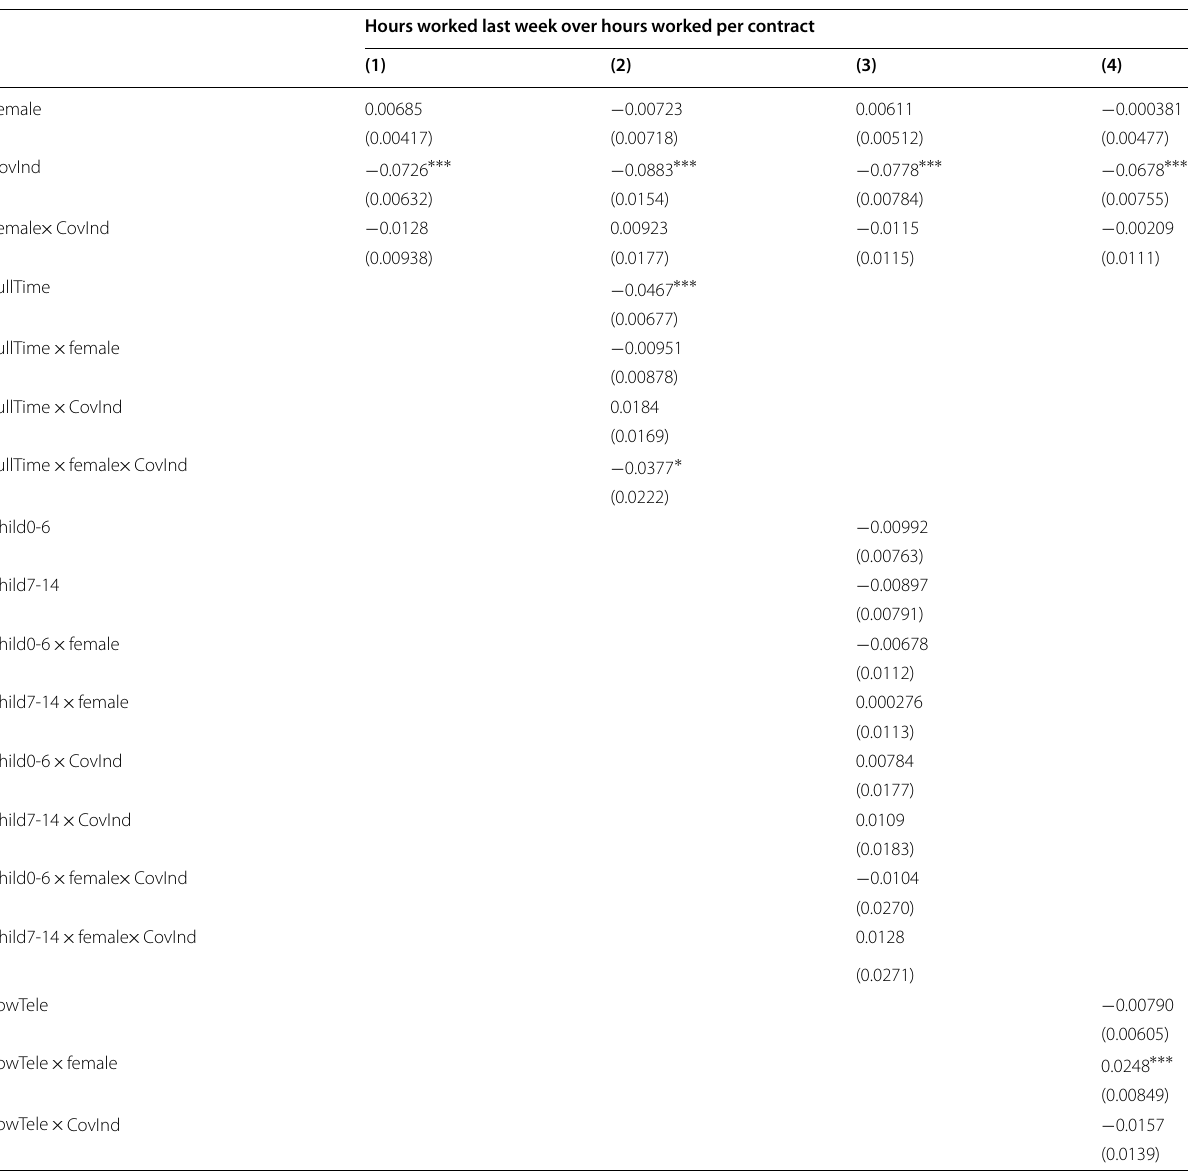
Table 9 The effect of COVID-19 and gender on relative hours